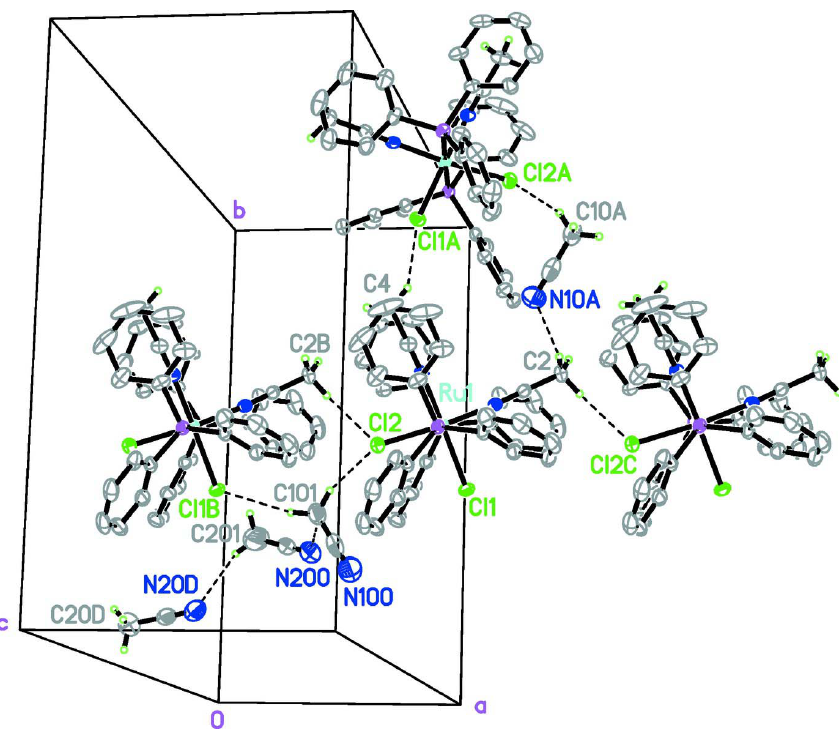
Figure 2 Packing diagram showing a portion of the network of weak hydrogen bonds involving acetonitrile C—H bonds. Symmetry codes: (A) 2 - x , 1/2 + y , 1/2 - z ; (B) -1 + x , y , z ; (C) 1 + x , y , z ; (D) -1/2 + x , 1/2 - y , - z . For solvent symmetry equivalents, N200 becomes N20A, etc